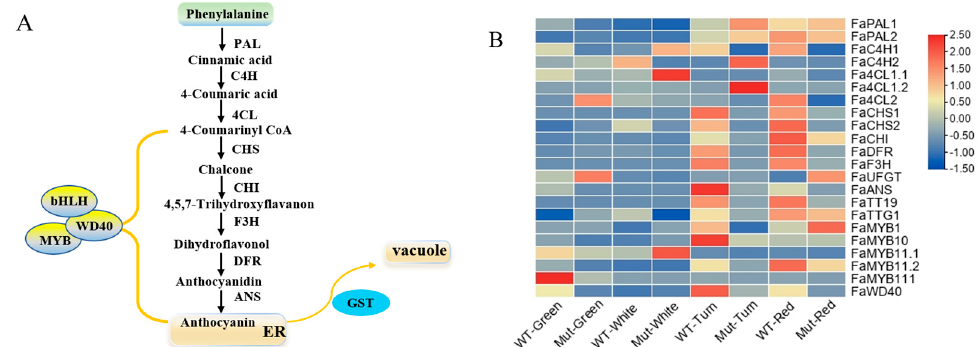
Figure 4. ( A ) Anthocyanin biosynthetic and regulatory pathway. The green box represents the precursor for anthocyanin biosynthesis; the yellow oval represents transcription factors regulating anthocyanins accumulation; the yellow box represents the endoplasmic reticulum and vacuole; the blue oval represents the anthocyanin transport gene. PAL is phenylalanine ammonia-lyase; C4H is cinnamate 4-hydroxylase; 4CL is 4-coumarate-CoA synthase; CHS is chalcone synthase; CHI is chalcone isomerase; F3H is flavanone 3-hydroxylase; DFR is dihydroflavonol-4-reductase; ANS is anthocyanidin synthase; MYB is MYB transcription factor; WD40 is WD-repeat protein; bHLH is basic helix-loop-helix transcription factor. ( B ) Expression levels of anthocyanins-related genes of ‘Sachinoka’ strawberry and its somaclonal mutant ‘Mixue’ fruit at four developmental stages. PAL is phenylalanine ammonia lyase; C4H is cinnamate 4-hydroxylase; 4CL is 4-coumarate-CoA synthase; CHS is chalcone synthase; CHI is chalcone isomerase; F3H is flavanone 3-hydroxylase; DFR is dihydroflavonol-4-reductase; UFGT is UDP glucose flavonoid-3-O-glycosyltranferase; TT19 is transparent testa 19; TTG1 is testa glabra 1; MYB is MYB transcription factor; WD40 is WD-repeat protein; ANS is anthocyanidin synthase.